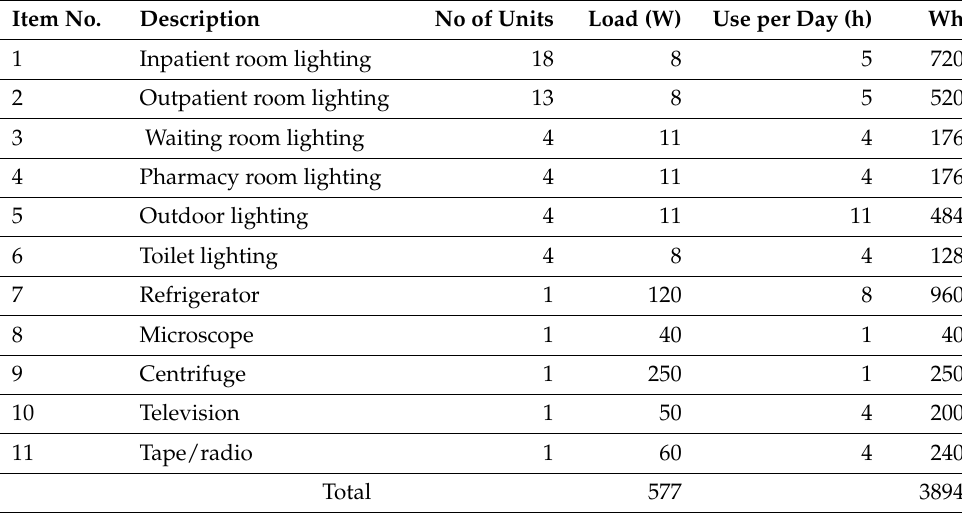
Table 1. Estimated load for health centers [12].